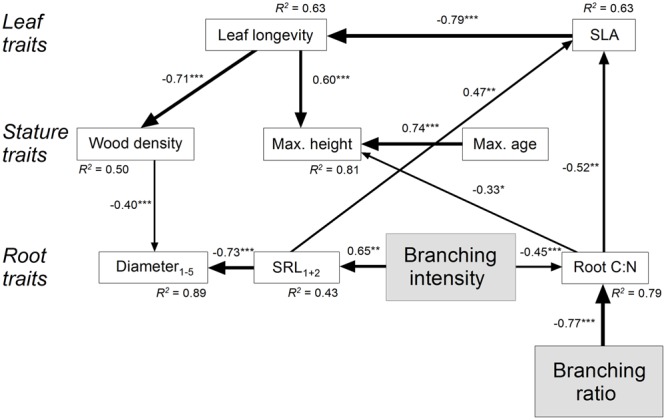
Structural equation model (χ2 = 44.4, df = 33, P = 0.09) on the effect of fine root branching ratio and branching intensity for leaf, stature, and root traits of major Central European tree species. The direction of the arrows indicates the direction of the influence; the line width illustrates the strength of the path. Path coefficients are standardized regression weights. The square of the coefficient of multiple correlations R2 is indicated at each variable. Regression weights of latent variables are fixed at unity. Significance is indicated as ∗P ≤ 0.05, ∗∗P ≤ 0.01, and ∗∗∗P ≤ 0.001. Insignificant paths and variables (leaf Nmass, root Nmass,1-5, fine root longevity, and tissue density1+2) were eliminated from the final SEM. Data for leaf longevity are log-transformed.